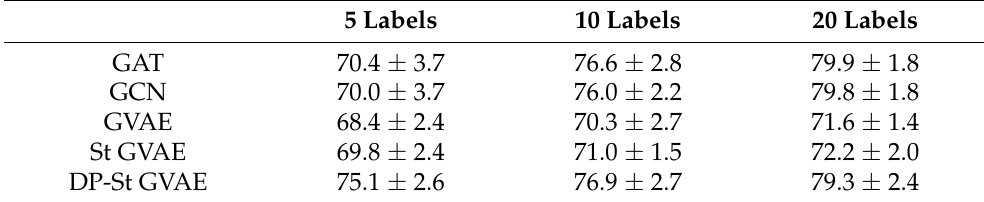
Table 5. Semi-supervised node classification prediction accuracy for Cora.